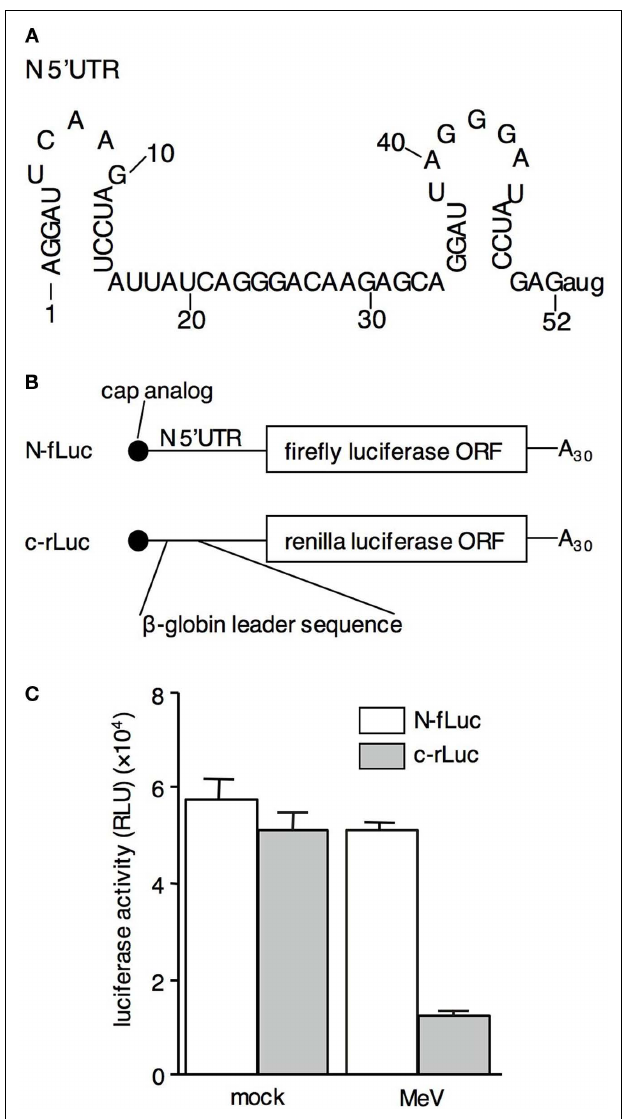
FIGURE 1 | RNA containing the N-5 (cid:2) UTR escapes the shutoff effect induced by MeVHL infection. (A) Sequence and computer-predicted structure of the wild-type N-5 (cid:2) UTR. (B) Structure of N-fLuc reporter RNA and c-rLuc reporter RNA.The 3 (cid:2) UTR and poly A tail of both types of RNAs, and the 5 (cid:2) UTR of c-rLuc RNA were derived from the pTNT vector. (C) Luciferase activity in mock- or MeV-infected B95a cells co-transfected with N-fLuc (white bar) and c-rLuc RNA (gray